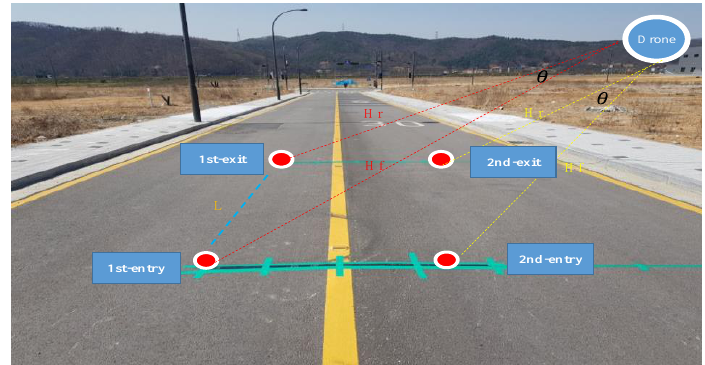
Figure 10. Vehicle detection experiment method on the first and second lines.